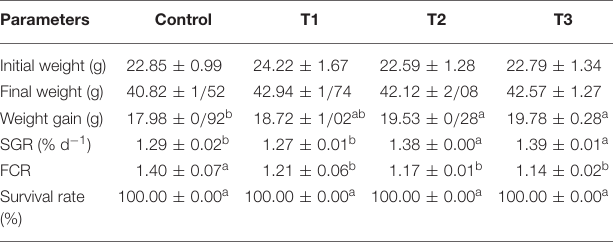
SGR, specific growth rate; FCR, feed conversion ratio. Data represent mean ± SE. Different letters in the same row indicate significant differences (p < 0.05).